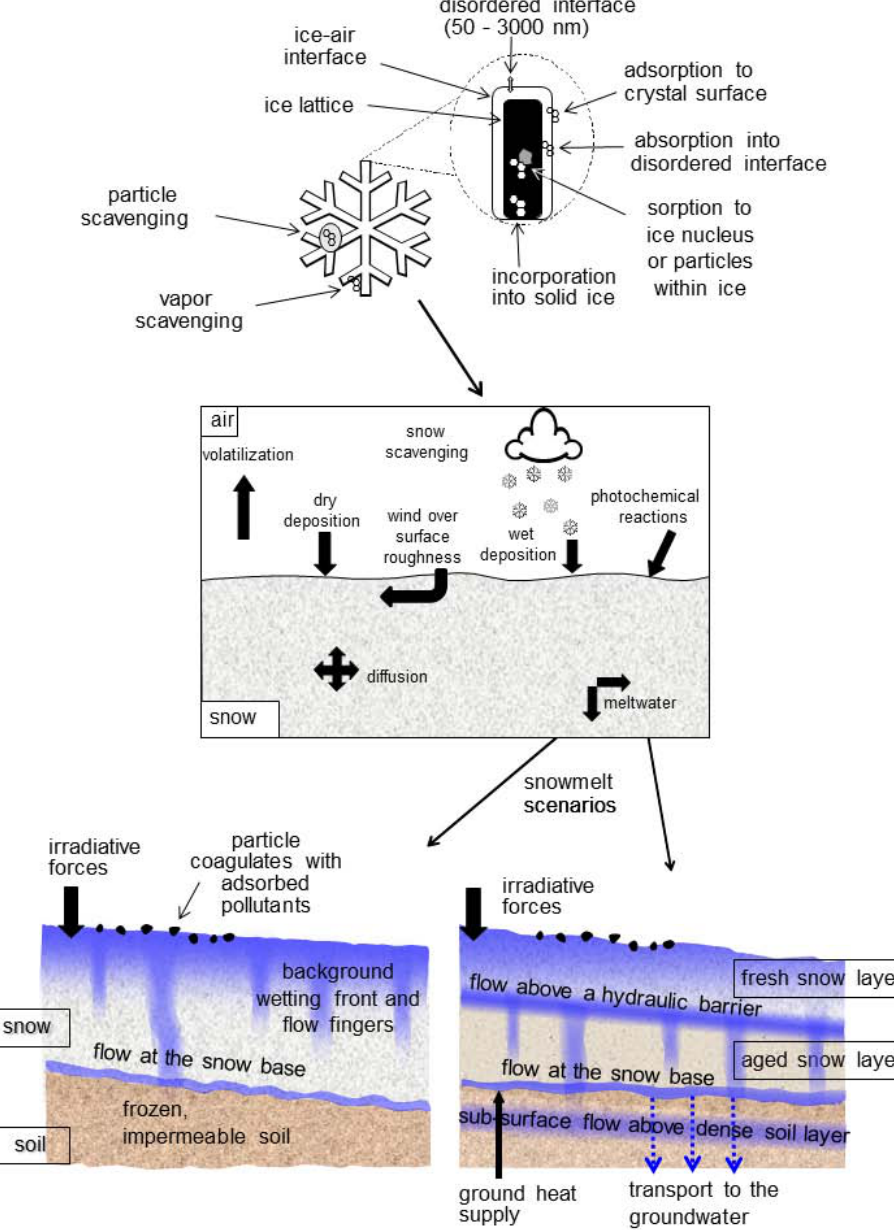
Fig. 2. Top illustration shows the various processes involved in organic contaminant partitioning to snow during deposition, including ad- sorption to the surface of the crystal, absorption into the disordered interface on the surface of the snow crystal, uptake into the solid-ice matrix or incorporation with the ice-forming nucleus or from particles present as a droplet freezes. Incorporation of contaminants may also occur by both vapor and particle scavenging. Middle illustration shows the various processes involved in cycling organic contaminants within a deposited snowpack, including deposition and revolatilization, wind-pumping (ventilation), photochemical reaction, and movement with meltwater. Bottom illustration shows two snowmelt scenarios, comparing a snowmelt process over soil typical of Arctic environments (left) where permafrost is present and in temperate environments (right) where hydraulic barriers are more prevalent and bottom-melt occurs due to the supply of heat from underlying ground. Figure adapted from Meyer and Wania (2008) and Herbert et al.